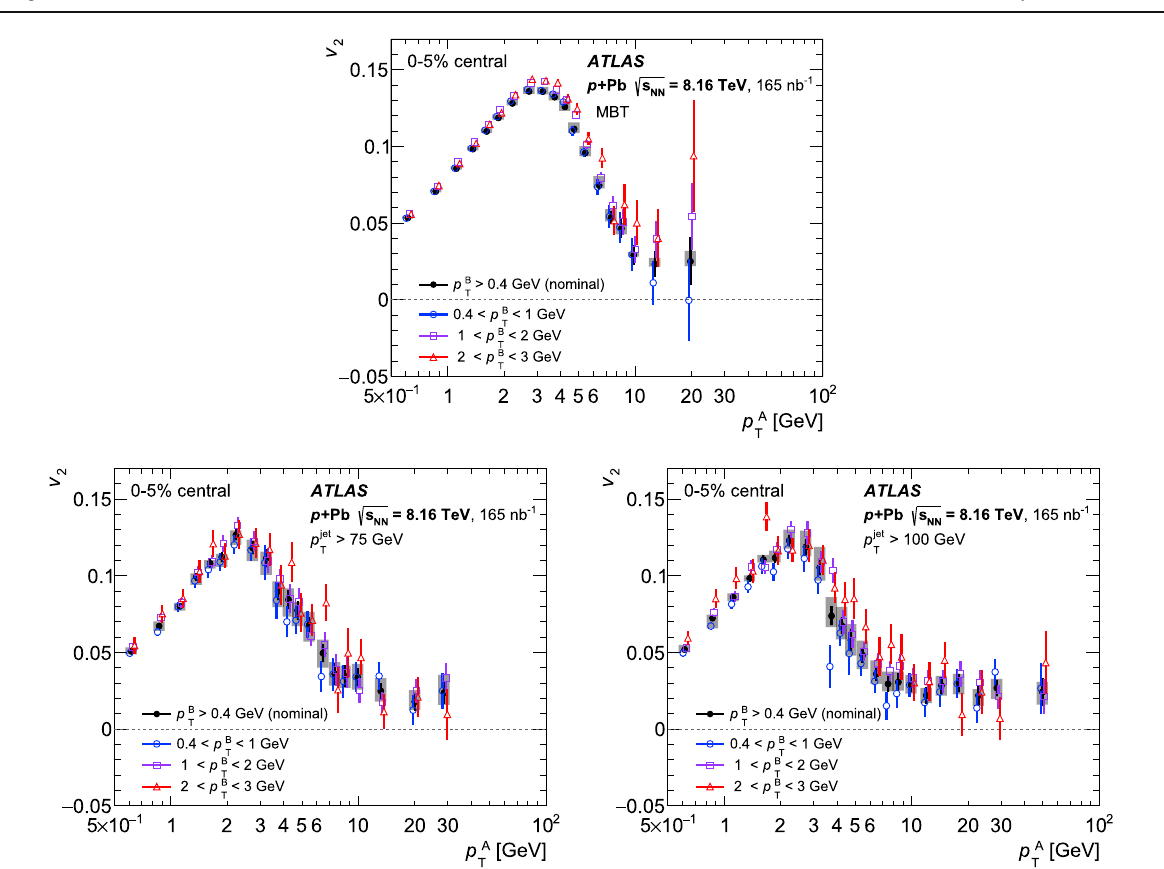
Fig. 4 Measured v 2 values plotted as a function of the A-particle p T triangles). The points with different B-particle p T selections are offset slightly from the nominal horizontal-axis positions to make the uncer- for MBT events (top), events with jet p T > 75 GeV (bottom left), tainties visible. For clarity, systematic uncertainties are omitted from and events with jet p T > 100 GeV (bottom right). The nominal values the three sets of restricted B-particle p T ranges; they are, however, con- (closed black circles) are overlaid with points generated by making dif- < 1 GeV (blue open circles), ferent B-particle p T selections: 0 . 4 < p B sistent with those from the inclusive results and are highly correlated T < 2 GeV(open violetsquares), and2 < p B < 3GeV(openred between the 1 < p B T T